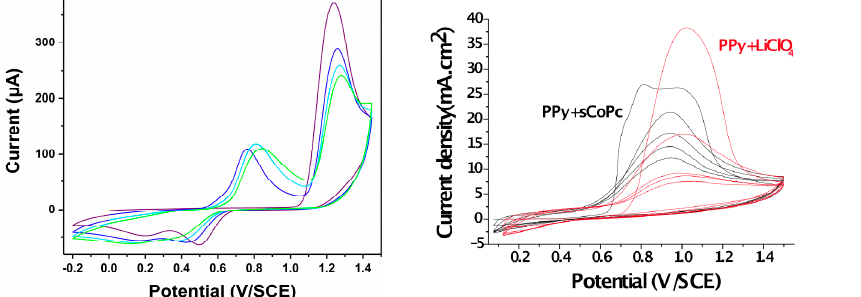
Figure 1. Cyclic voltammetry on glassy Carbon of TFA 30 mM in HClO 4 0.66 M, v = 0.1 V·s − 1 ( left ) and of aqueous solutions of 0.1 mol·L − 1 pyrrole and 0.1 mol·L − 1 LiClO 4 or 0.01 mol·L − 1 ·s-CoPc ( right ).